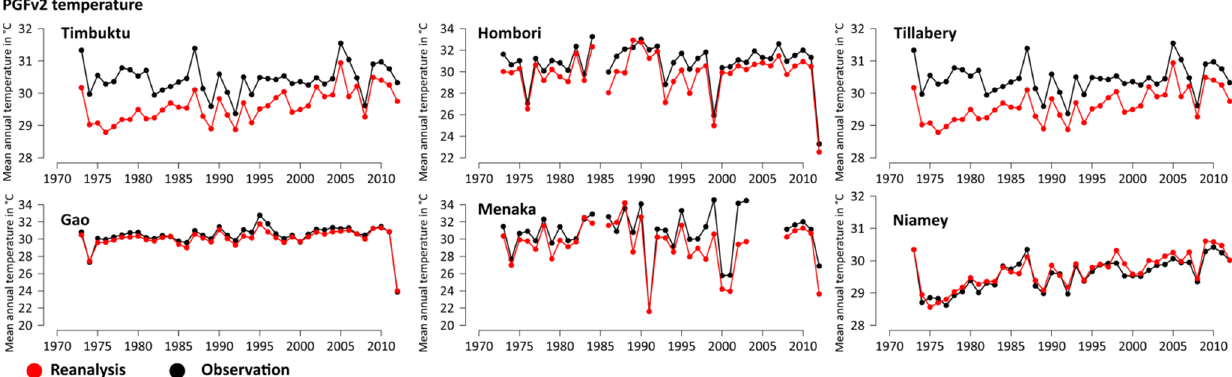
Figure 5. Comparison of mean annual temperature of interpolated PGFv2 reanalysis data (red) with observations from six weather stations (black) in the research